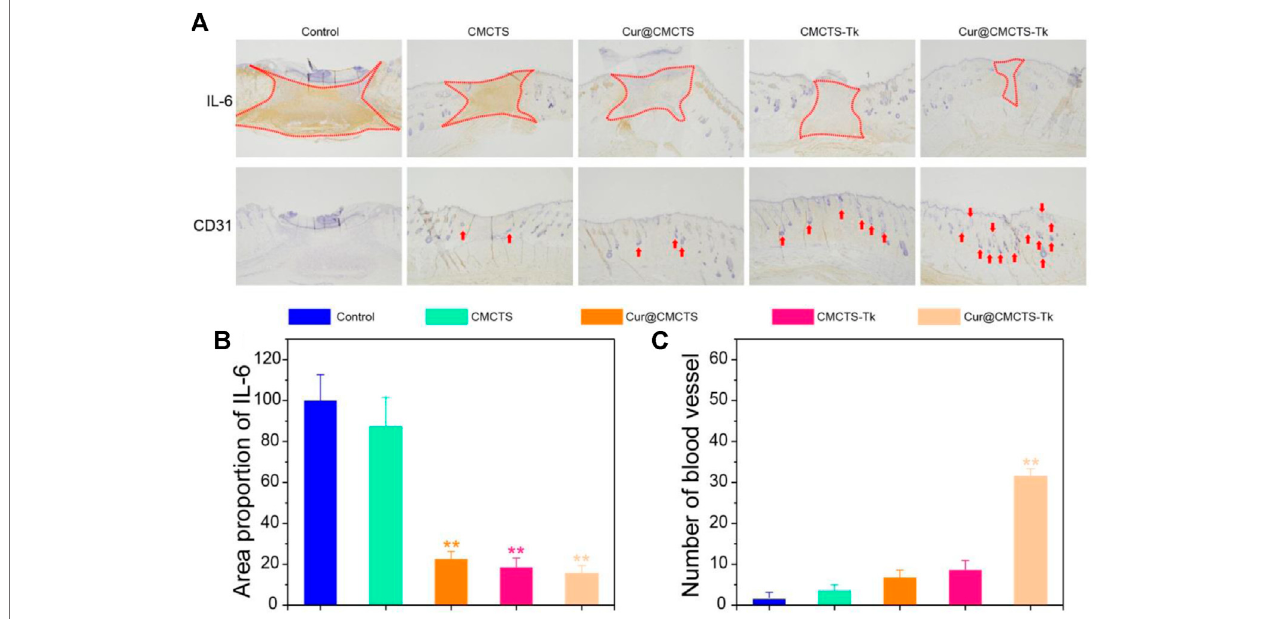
FIGURE9| In fl ammatory factorand vascularizationintheburnwoundstreatedwithCur@CMCTS-Tkhydrogel. (A) IL-6andCD31immunohistochemistrystaining inthewoundstreatedwithCur@CMCTS-Tkhydrogelinfull-thicknessburnsratmodelatday21.ExpressionofIL-6 (B) andquanti fi cationofthenumberofbloodvessels (C) in the wounded area using ImageJ software ( n (cid:2)